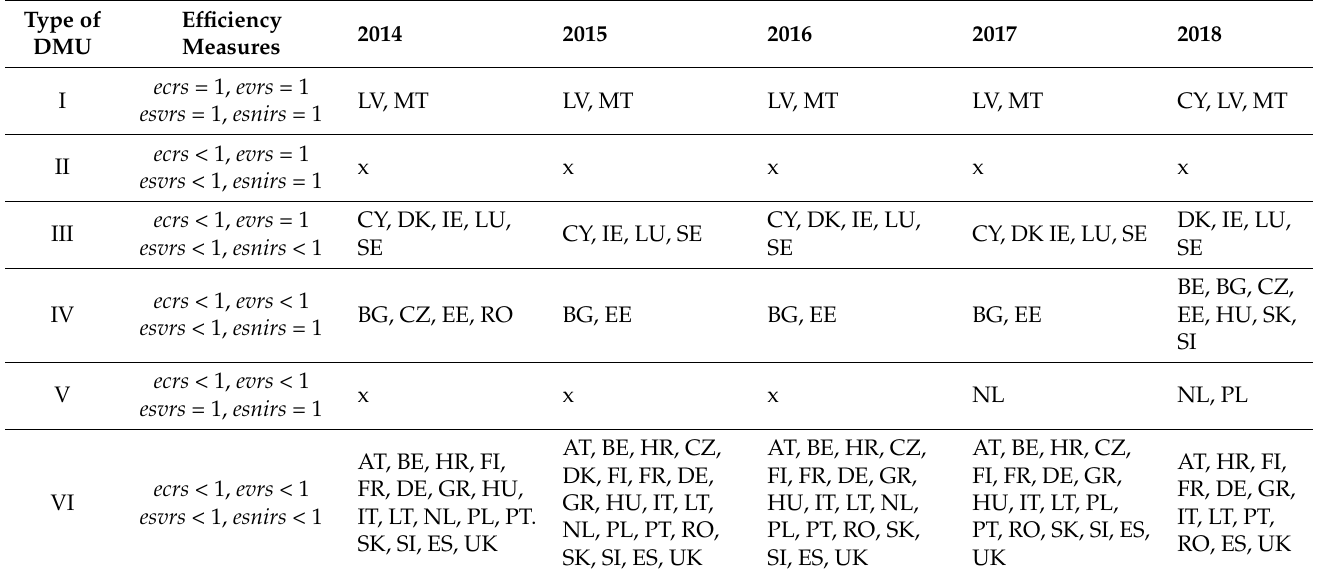
Table 3. Results of the efficiency of implementing climate/energy targets for EU countries in